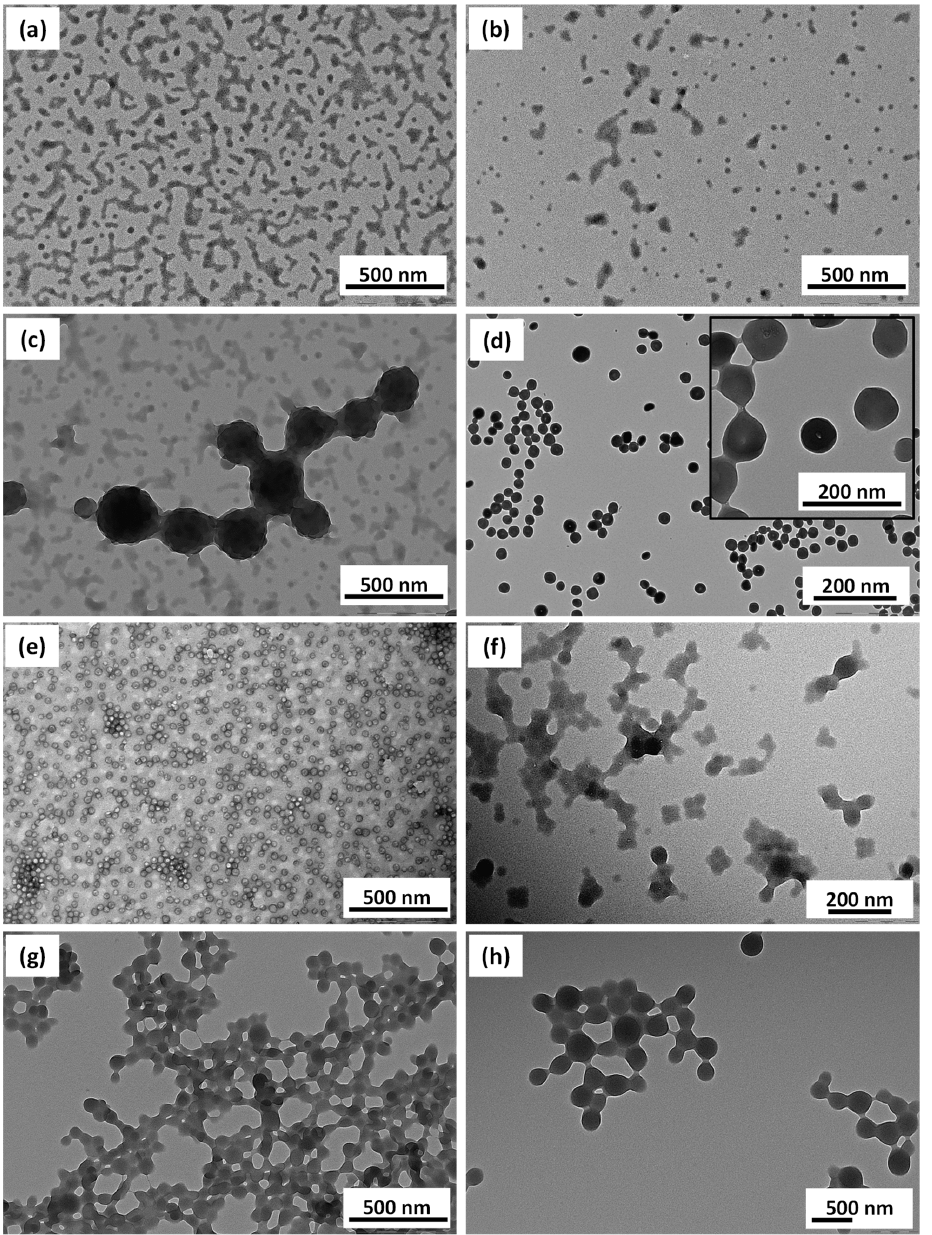
Figure 4. TEM images obtained for PDMA 39 –PHFBMA x - PBzMA y nano objects prepared at 10% w / w with ( a ) x = 50, y = 69; ( b ) x = 99, y = 69; ( c ) x = 149, y = 69; ( d ) x = 199, y = 66; ( e ) x = 50, y = 198; ( f ) x = 99, y = 198; ( g ) x = 149, y = 198; ( h ) x = 199, y = 198.